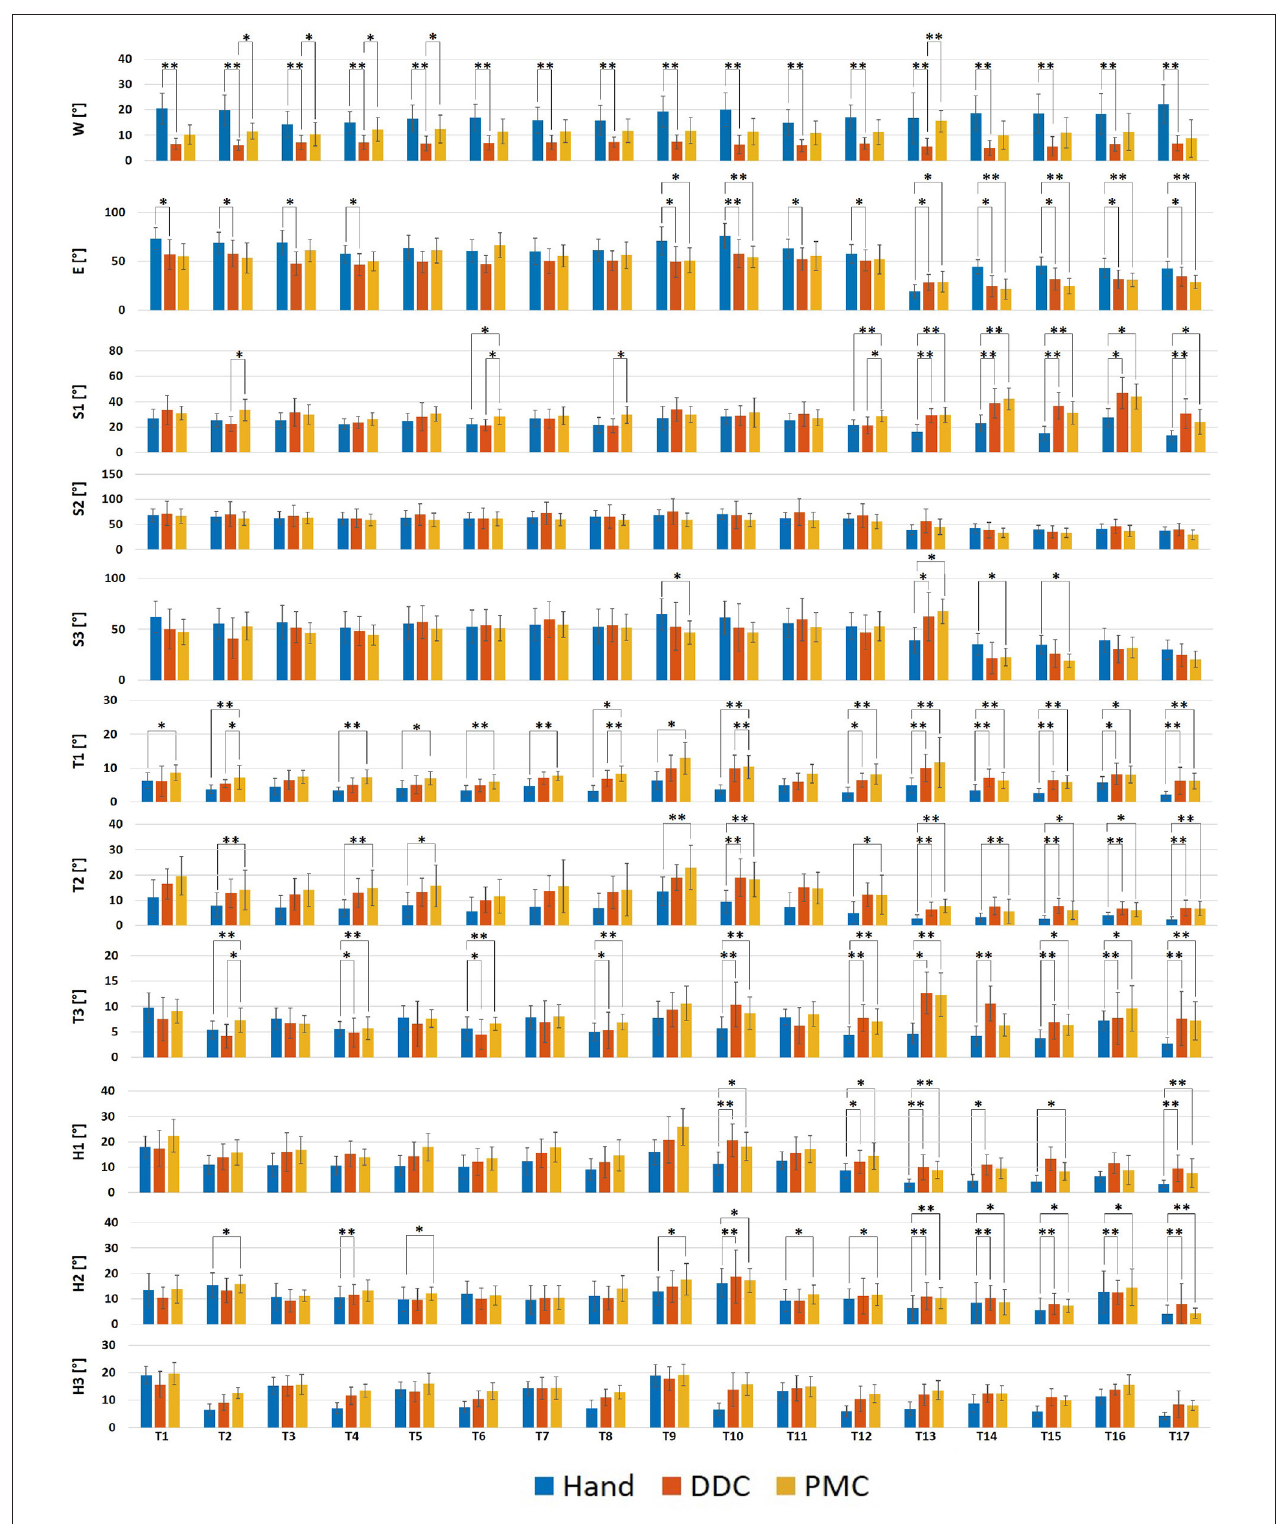
FIGURE 7 | Bar plots showing the median values and the standard deviations upon all the subjects of the RoM obtained during the execution of the tasks in the three configurations tested. S1, Shoulder abduction/adduction; S2, Shoulder flexion/extension; S3, Shoulder rotation; E, Elbow flexion/extension; W, Wrist pronation/supination; T1, Trunk abduction/adduction; T2, Trunk flexion/extension; T3, Trunk rotation; H1, Head abduction/adduction; H2, Head flexion/extension; H3, Head rotation. * p < 0.05, ** p < 0.01.